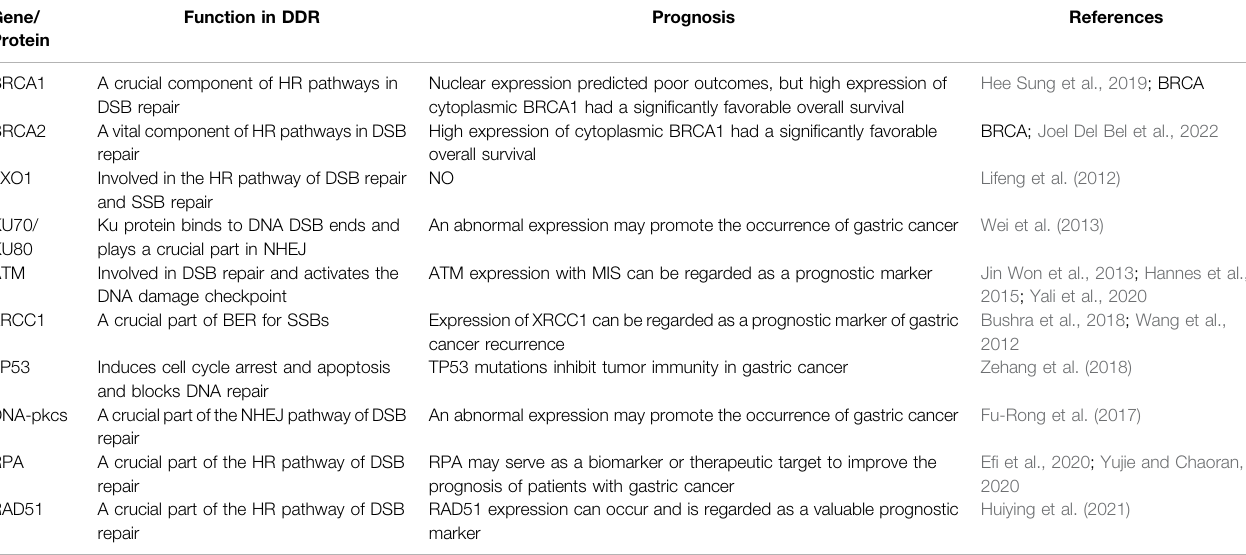
TABLE 1 | Genes/proteins involved in DDR in gastric cancer